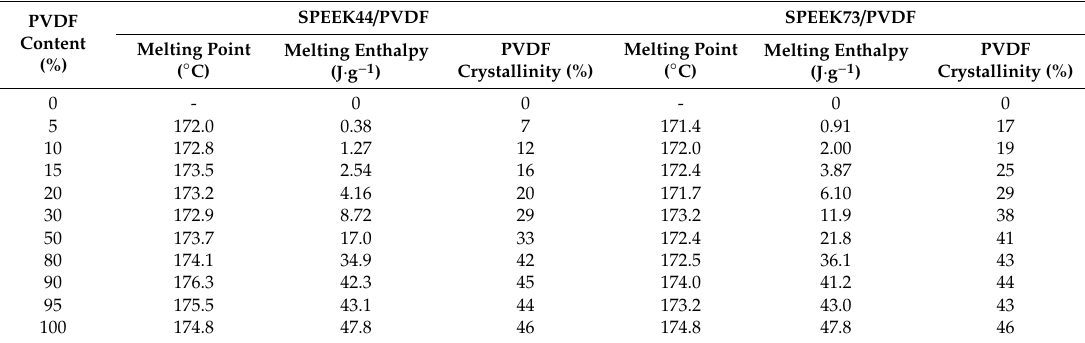
Figure 4. DSC curves of ( a ) SPEEK44 / PVDF and ( b ) SPEEK73 / PVDF blend membranes with different PVDF contents. Table 2. Melting point, melting enthalpy and crystallinity of PVDF in the SPEEK44 / PVDF and SPEEK73 / PVDF blend membranes derived from DSC